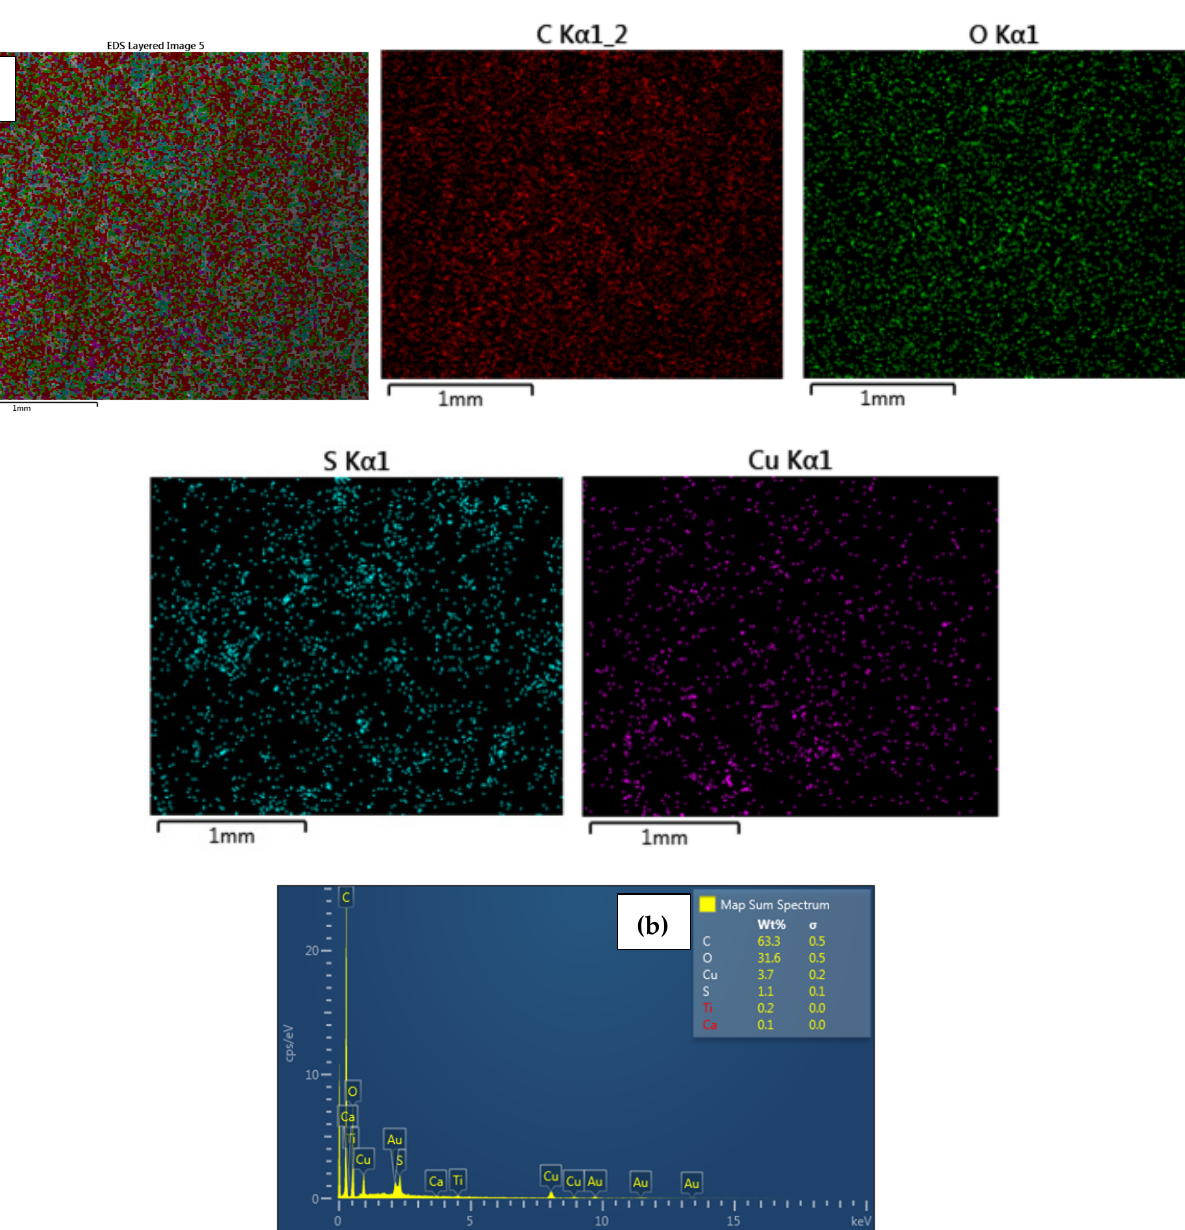
Figure 6. Elemental maps showing the composition of the analyzed AEM membrane surface; ( a ) combined elemental mapping of C, S, O and Cu and ( b ) EDS spectra confirming the presence of CuNPs of AEM-Cu3 nanocomposite membrane.